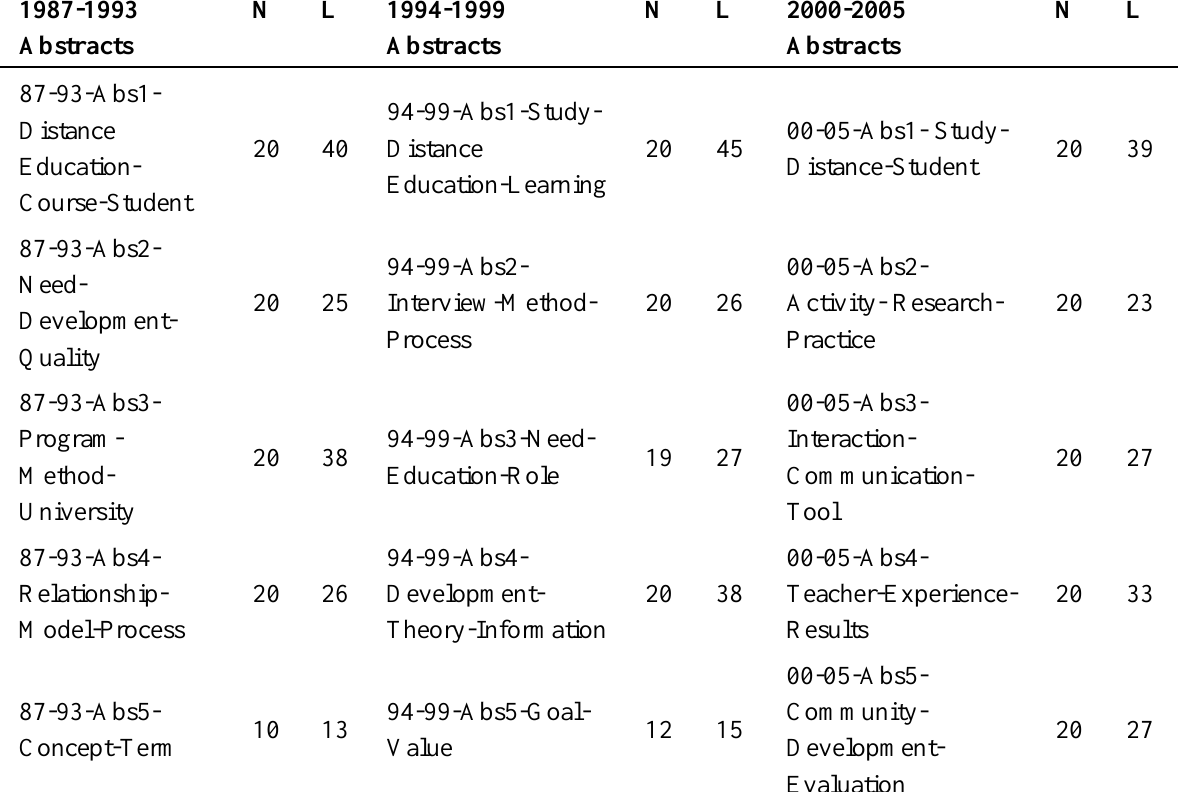
Lexical Maps Generated for Abstracts by Time